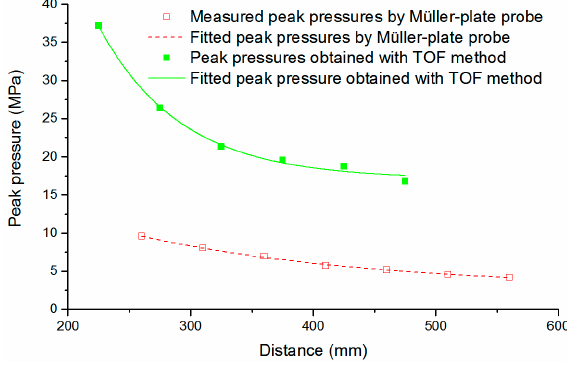
Figure 12. SW peak pressures obtained by the TOF method.